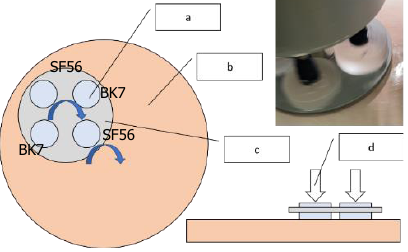
Fig. 2. Sketch and photograph of the polishing experiment. The components are (a) glass lens, (b) polishing pad, (c) lens holder and (d) force. The lens diameter is 40 mm. Polishing slurry is constantly fed to the polishing pad.